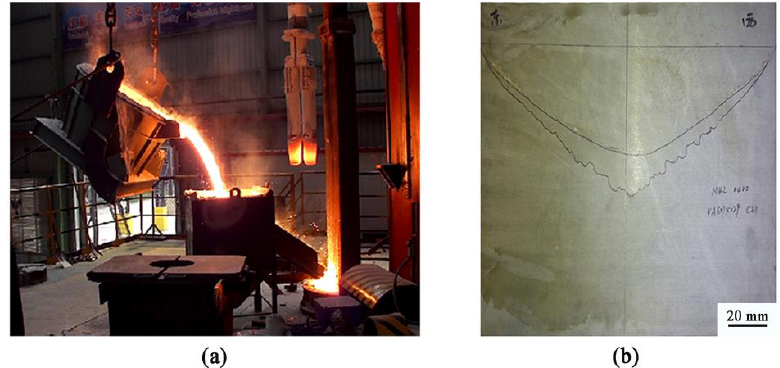
Figure 20. The experiment of TSCE-ESR process. ( a ) Photo of the TSCE-ESR plant experiment. ( b ) Molten metal pool structure in the process of TSCE-ESR.